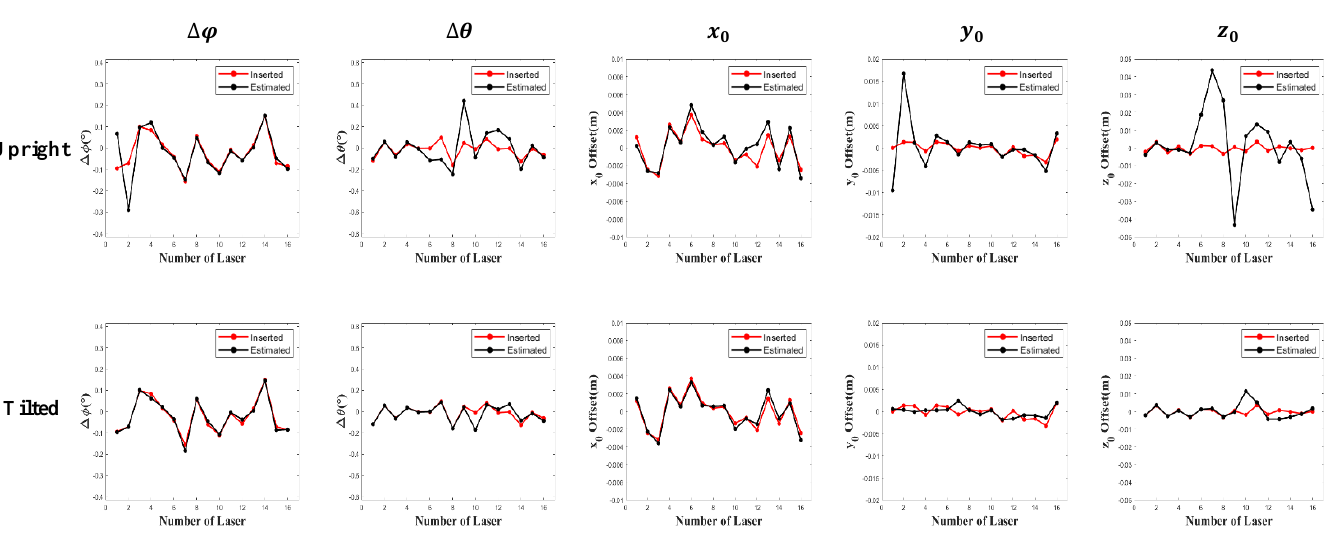
Figure 6. Inserted and estimated intrinsic parameters of each laser of two scanning